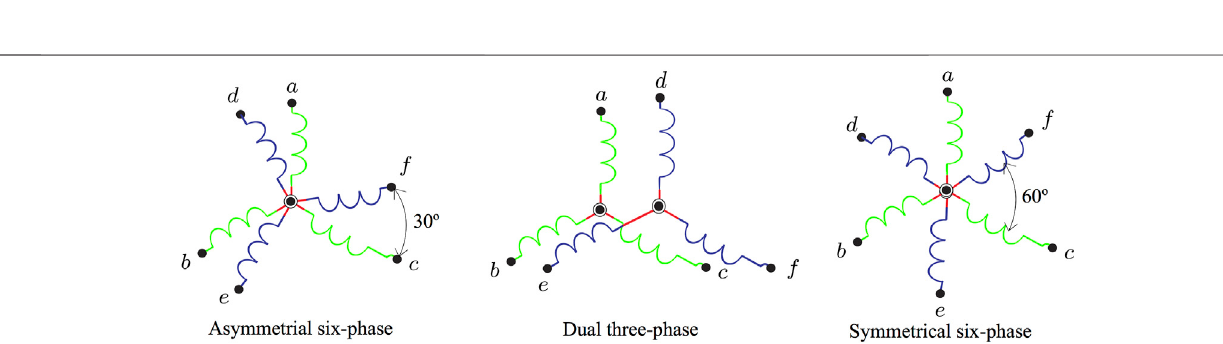
FIGURE 3 | Projections of the voltage vectors in the α − β (left) and x − y (right) planes for a symmetric fi ve-phase MI. The number that de fi nes each voltage is the decimal equivalent of the binary number [ S a , S b , S c , S d , S e ].